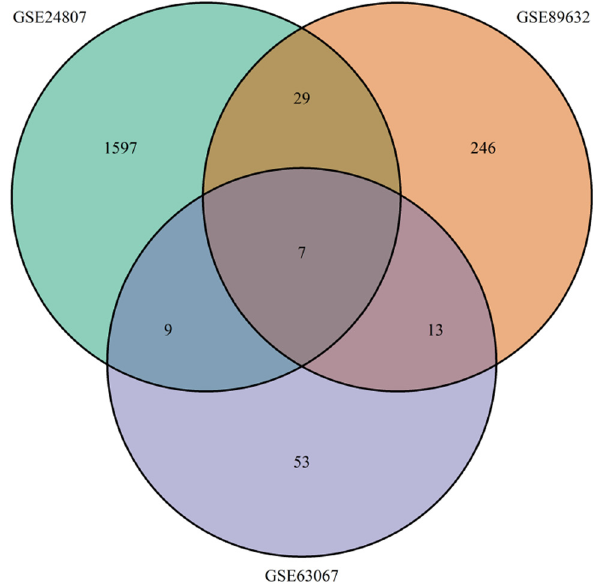
Figure 1: Venn diagram of di ff erentially expressed genes ( DEGs ) . Di ff erent colors represented di ff erent datasets, and the cross parts stood for common DEGs. Seven DEGs were shared with GSE24807, GSE63067, and GSE89632; nine DEGs were shared with GSE24807 and GSE63067; 29 DEGs were shared with GSE24807 and GSE89632; 13 DEGs were shared with GSE89632 and